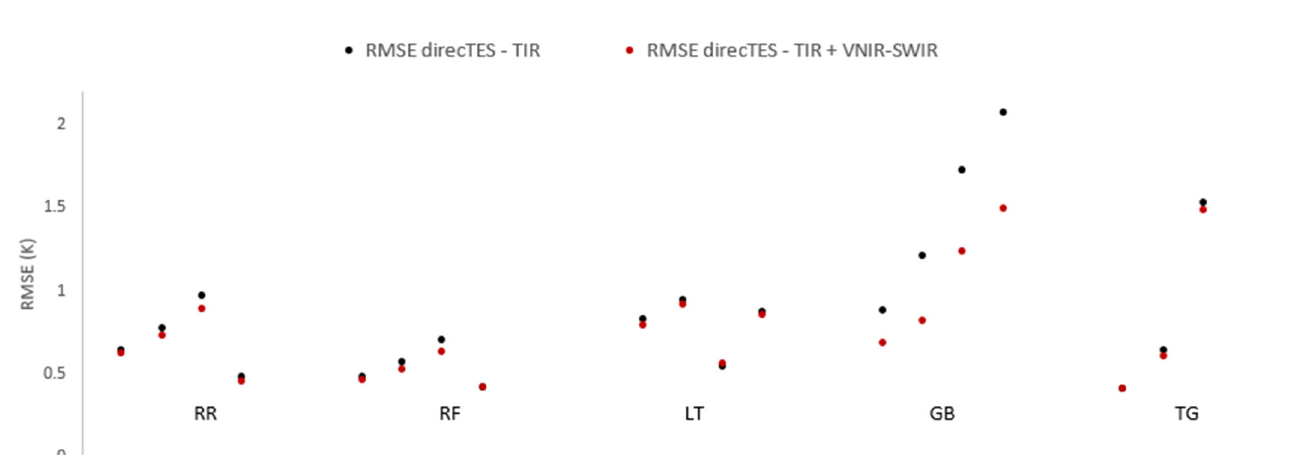
Figure 17. RMSE between ECOSTRESS and DirecTES TIR and DirecTES TIR + VNIR-SWIR LST on the whole images containing the 5 selected sites.